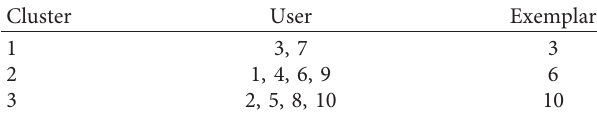
Table 4: Users in each cluster with exemplar.